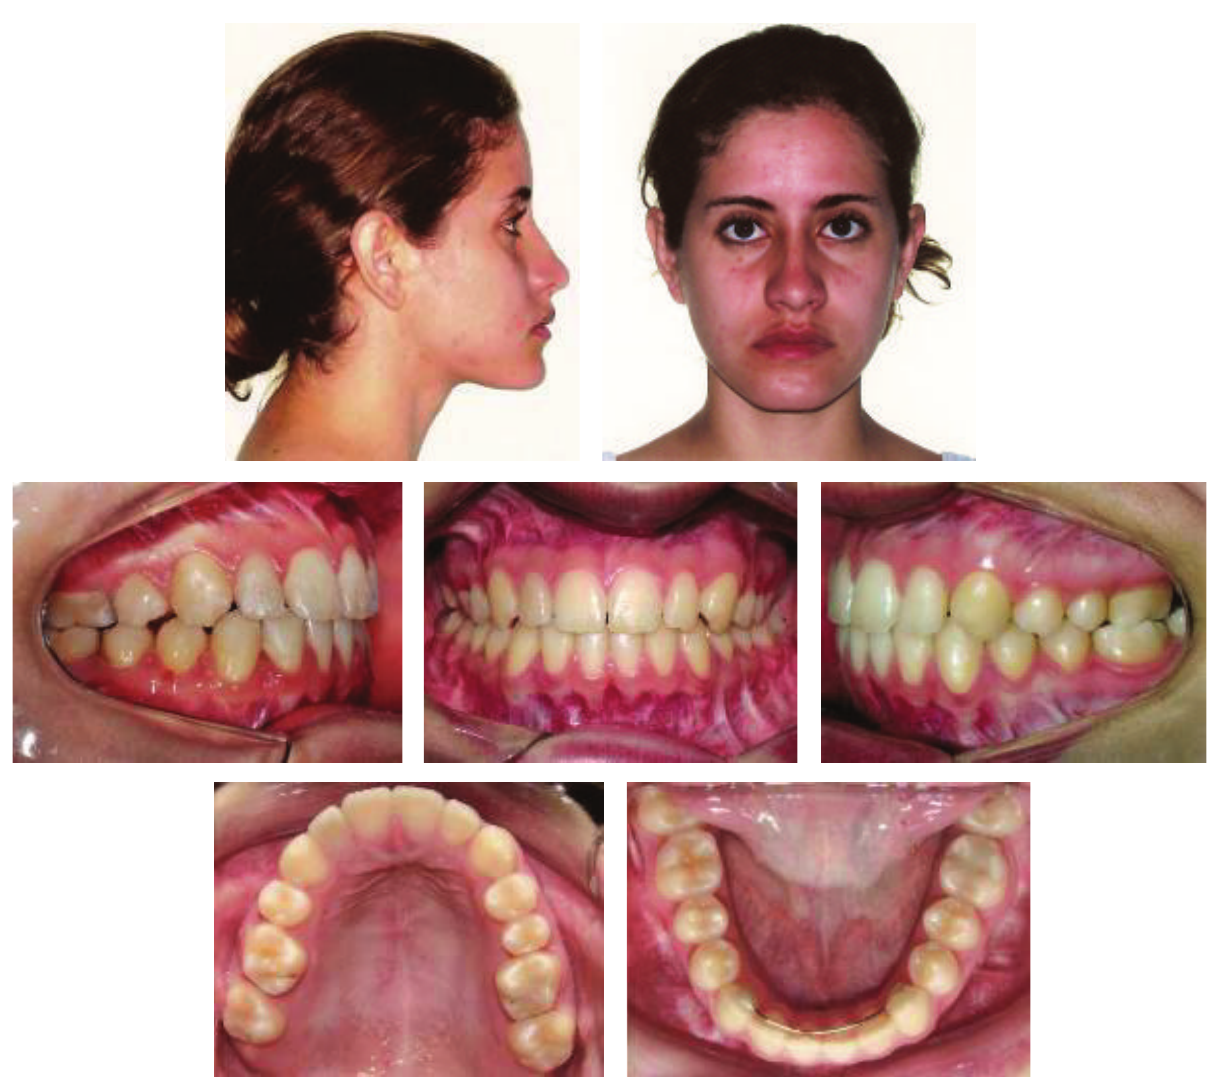
Figure 6: Posttreatment extraoral and intraoral